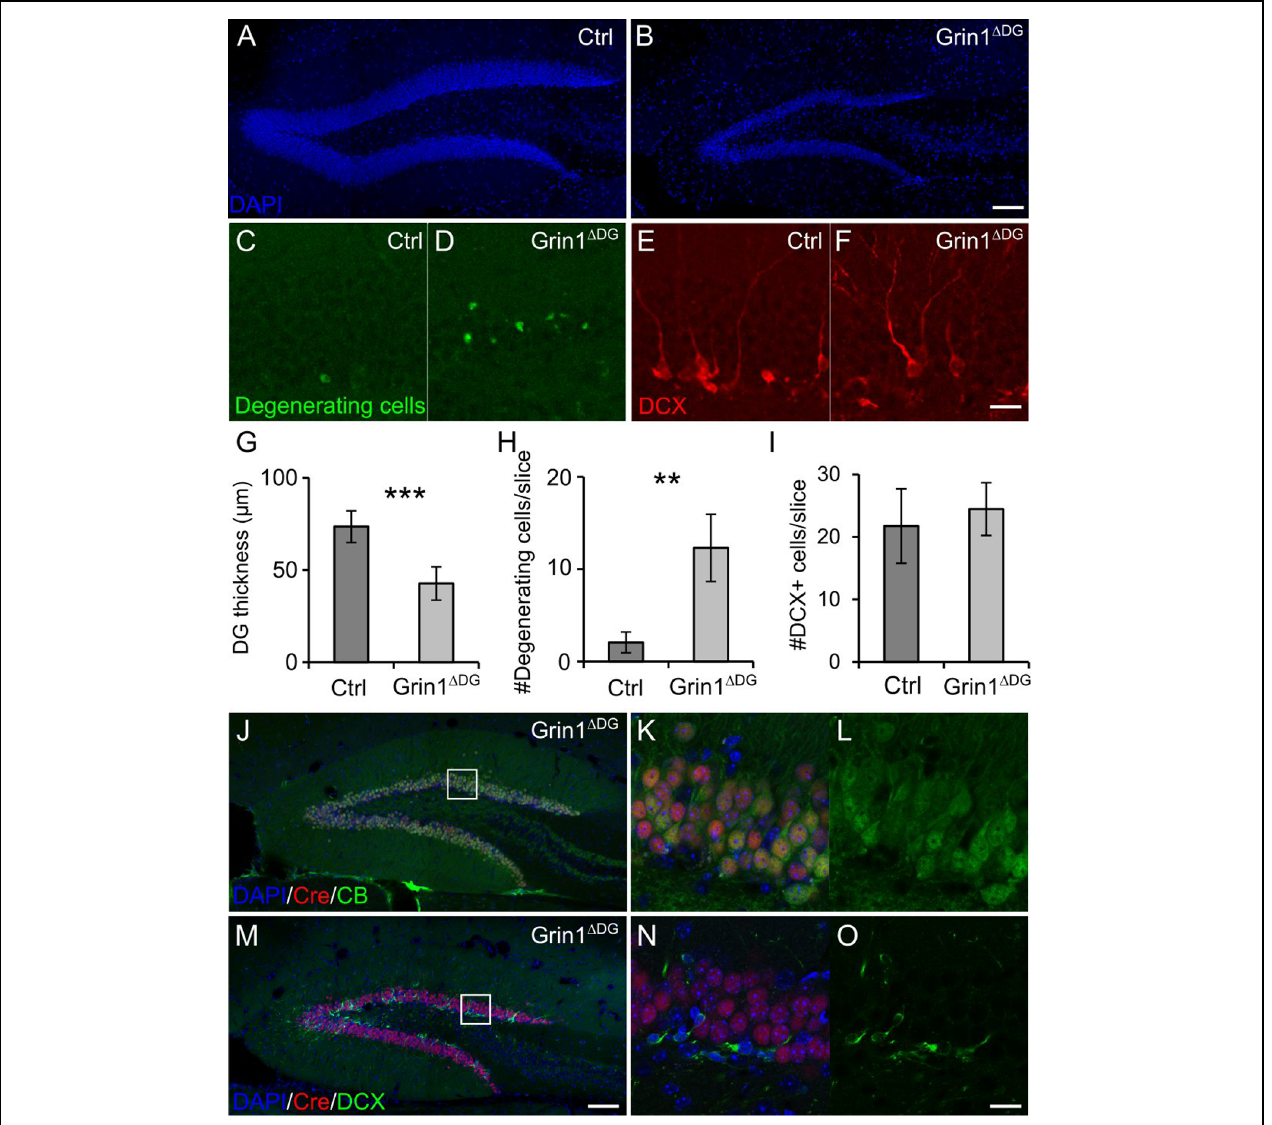
FIGURE 3 | DG selective deletion of GluN1 in Grin1 (cid:2) DG recapitulates the phenotype observed in Grin1 (cid:2) DGCA 1 mice. (A) DAPI stained section showing the DG of a 6 months old control mouse. (B) DAPI stained section from a 6 months old Grin1 (cid:2) DG mouse brain showing thinning of the DG. (C–F) Degenerating cells [green in (C,D) ] and DCX-positive cells [red in (E,F) ] in the DG of a 6 months old control and Grin1 (cid:2) DG mouse. (G) DG thickness is reduced in Grin1 (cid:2) DG